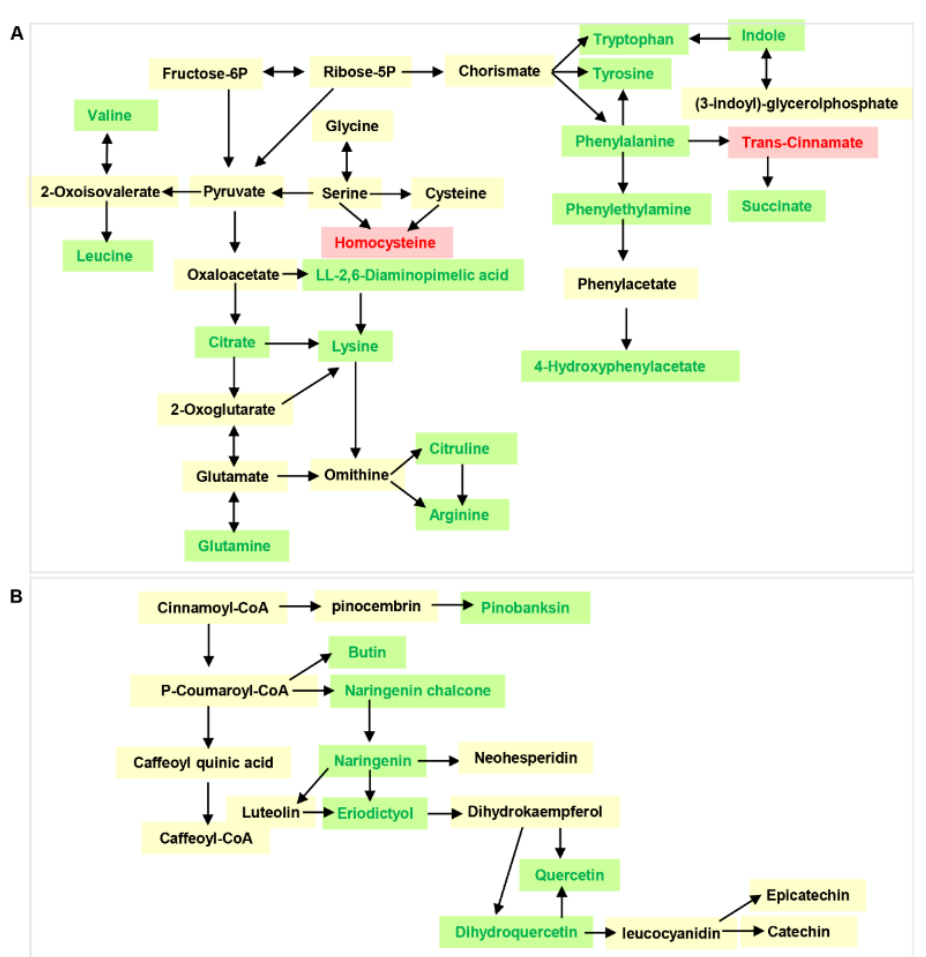
Figure 5. The differentially accumulated metabolites (DAMs) involved in amino acids and flavonoid metabolism. ( A ) The DAMs in CL enriched in biosynthesis of amino acids and related pathway comparing “JX” with “CA”. ( B ) The DAMs in LP enriched in flavonoid biosynthesis pathway comparing “JX” with “CA”. Green color indicated down-accumulated and red color indicated up-accumulated in “JX”. “CA”, China Antique; “JX”, JianXuan-17; CL, cotyledon; LP, lotus plumule.